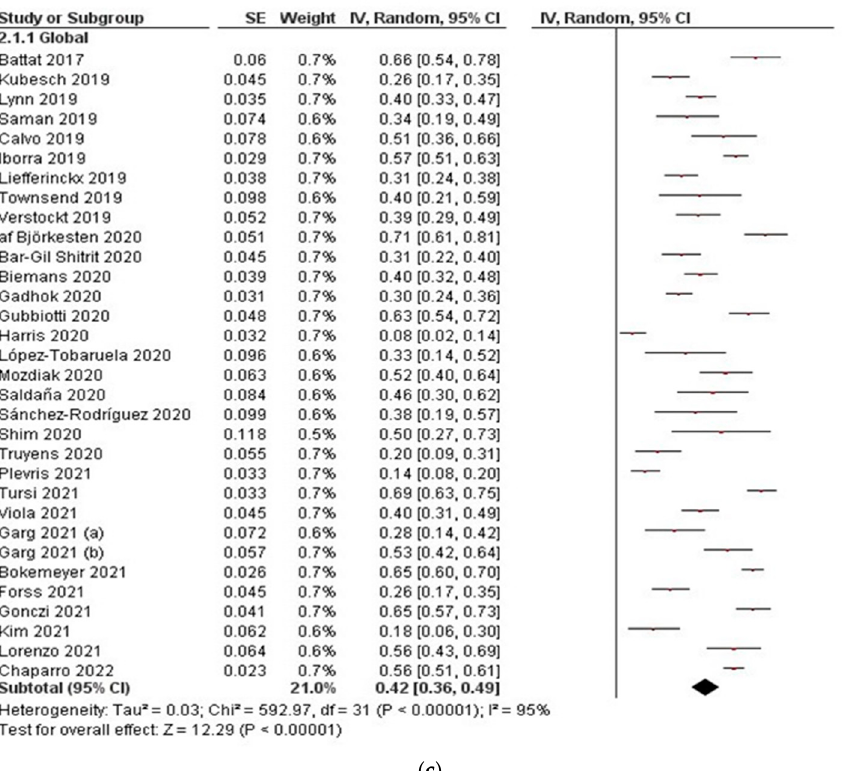
Figure 3. Clinical remission associated with ustekinumab in Crohn’s disease: ( a ) clinical remission in the short term (8 w–14 w); ( b ) clinical remission in the medium term (16 w–24 w); ( c ) clinical remission in the long term (48 w–52 w).